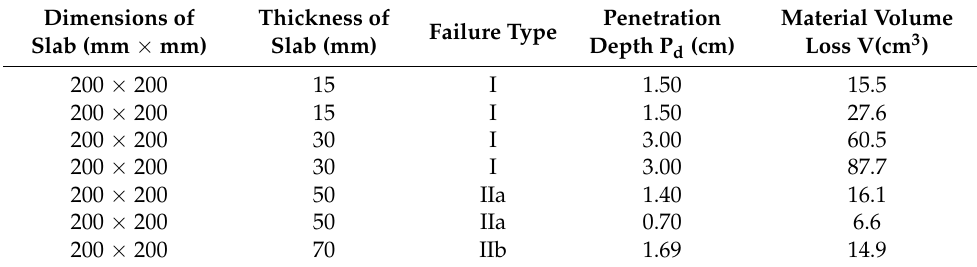
Table 5. Projectile impact results for mixture 6(5-1)/16/6.